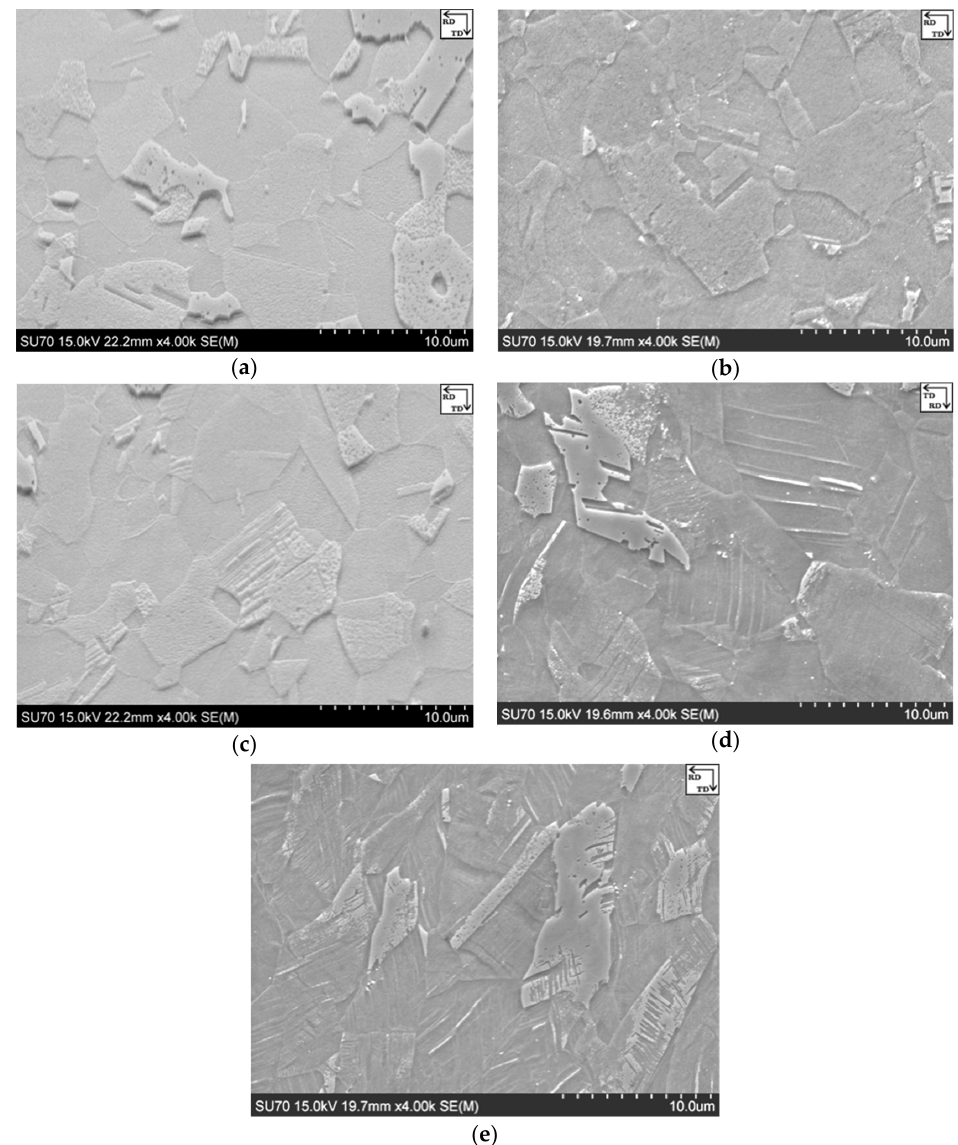
Figure 16. Scanning electron microscopy (SEM) images of: ( a ) an undeformed sample; ( b ) a 10% deformed sample; ( c ) a 20% deformed sample; ( d ) a 30% deformed sample ( e ) a deformed sample until maximum force was reached.